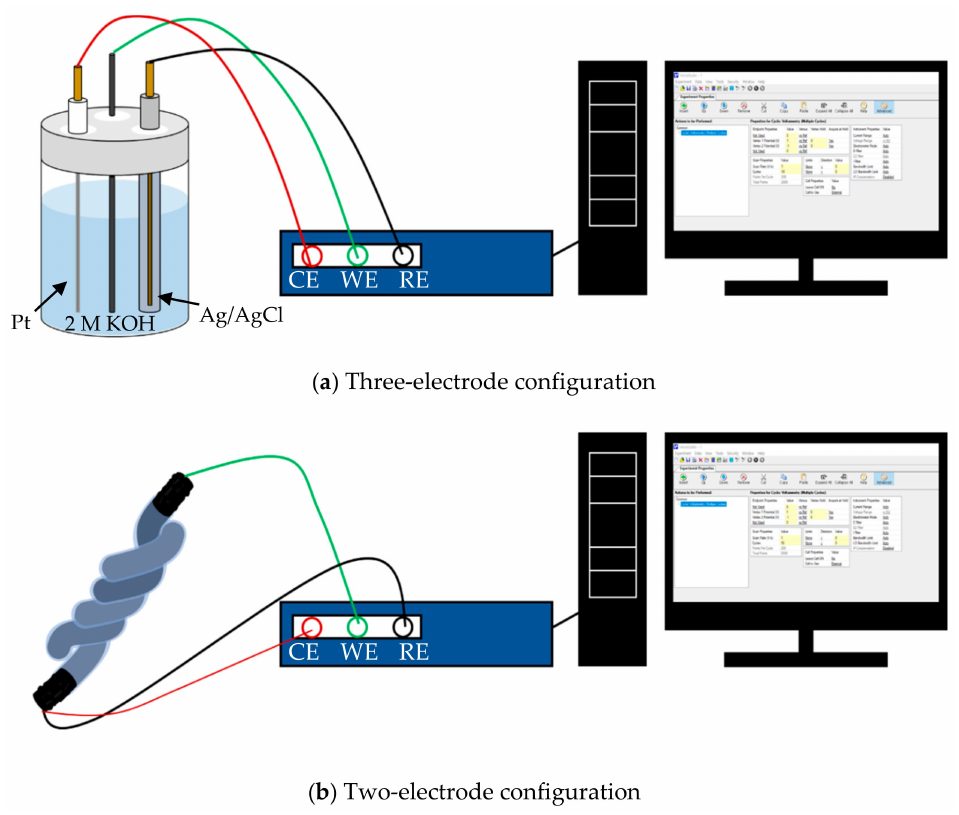
Figure 3. Electrochemical set-up of ( a ) three-electrode and ( b ) two-electrode